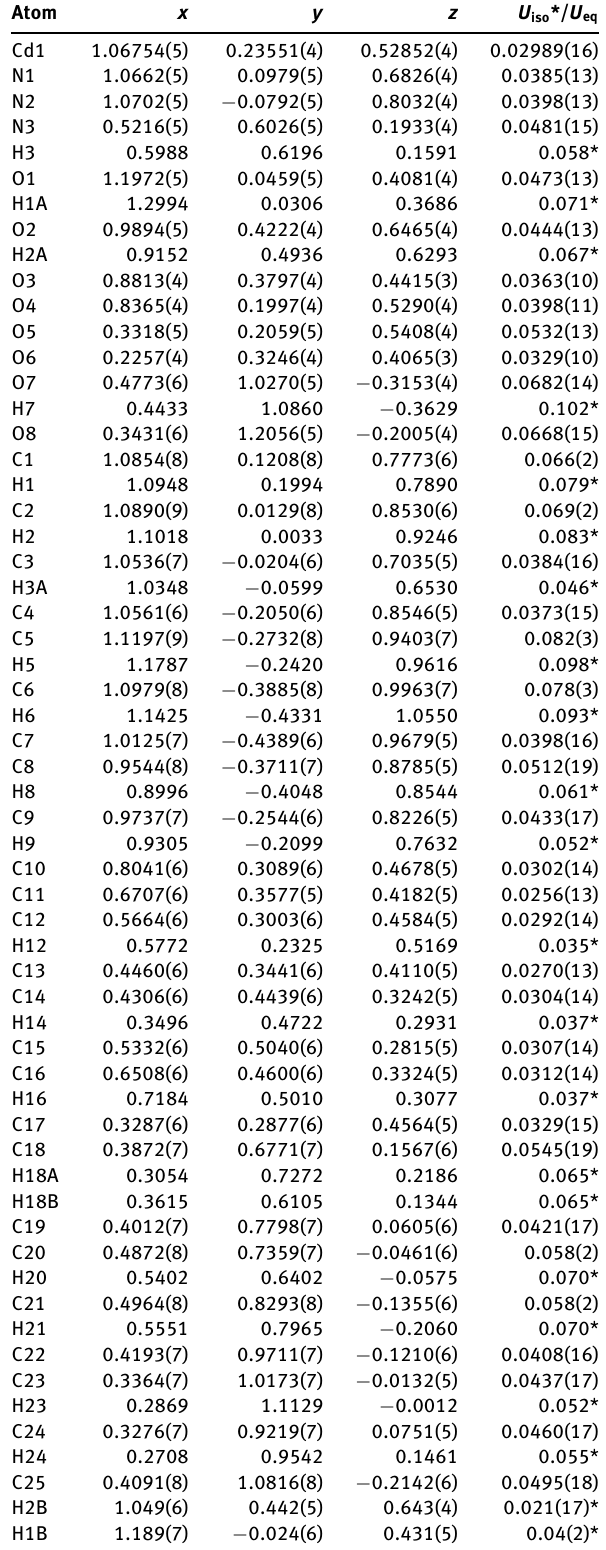
Table 2: Fractional atomic coordinates and isotropic or equivalent isotropic displacement parameters (Å 2